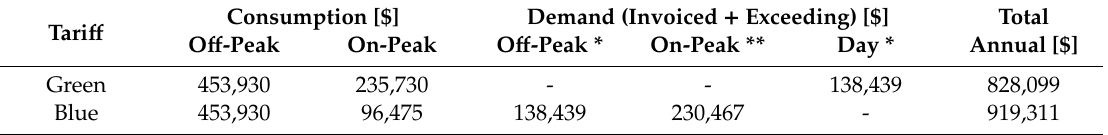
Table 8. Main results for Scenario 4.